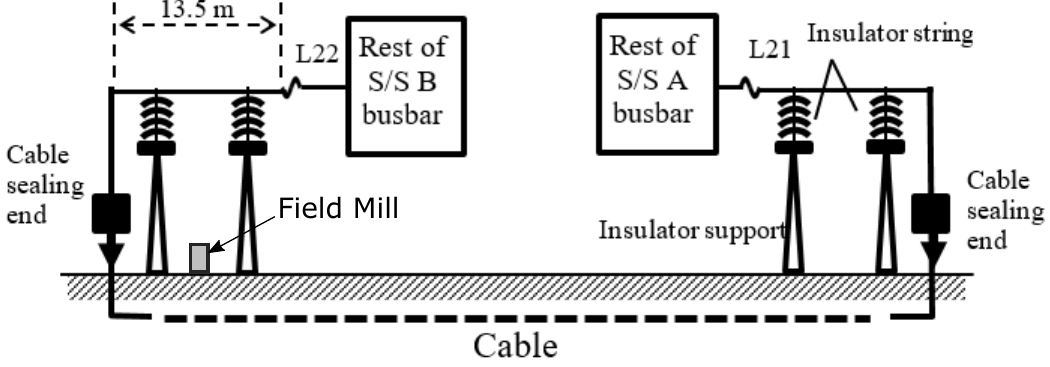
Figure 1. Diagrams associated with the test setup